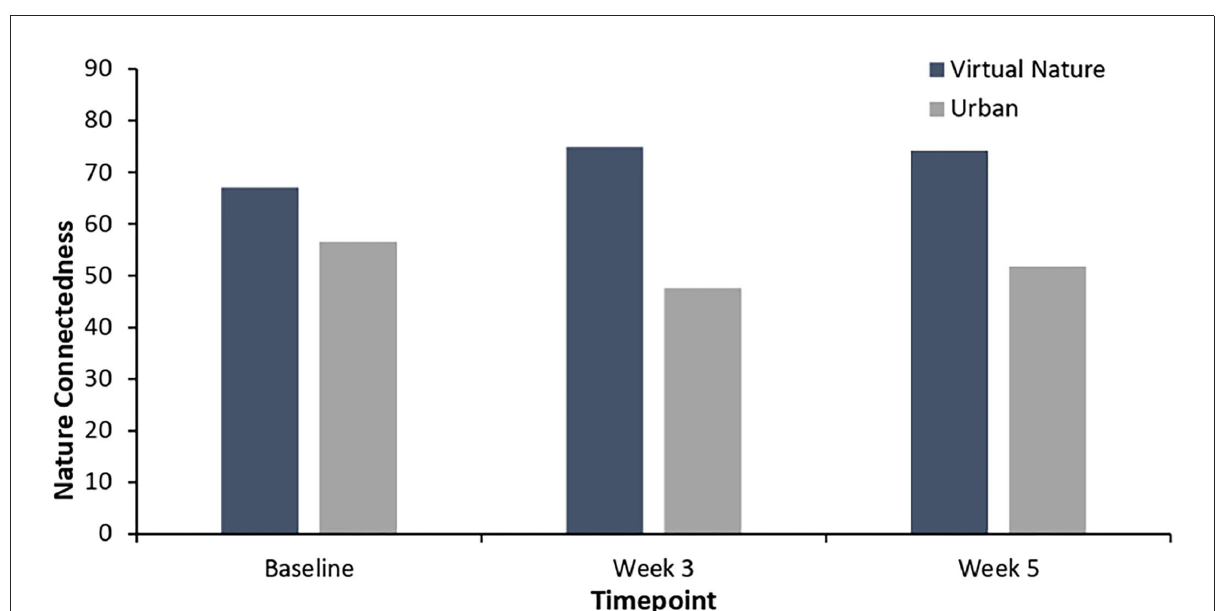
FIGURE2 Nature connectedness in the virtual nature group and urban group from baseline to week 5. Levels of nature connectedness in the virtual nature group were higher than in the urban group in weeks 3 and 5. There was an increase in nature connectedness in weeks 3 and 5 over the